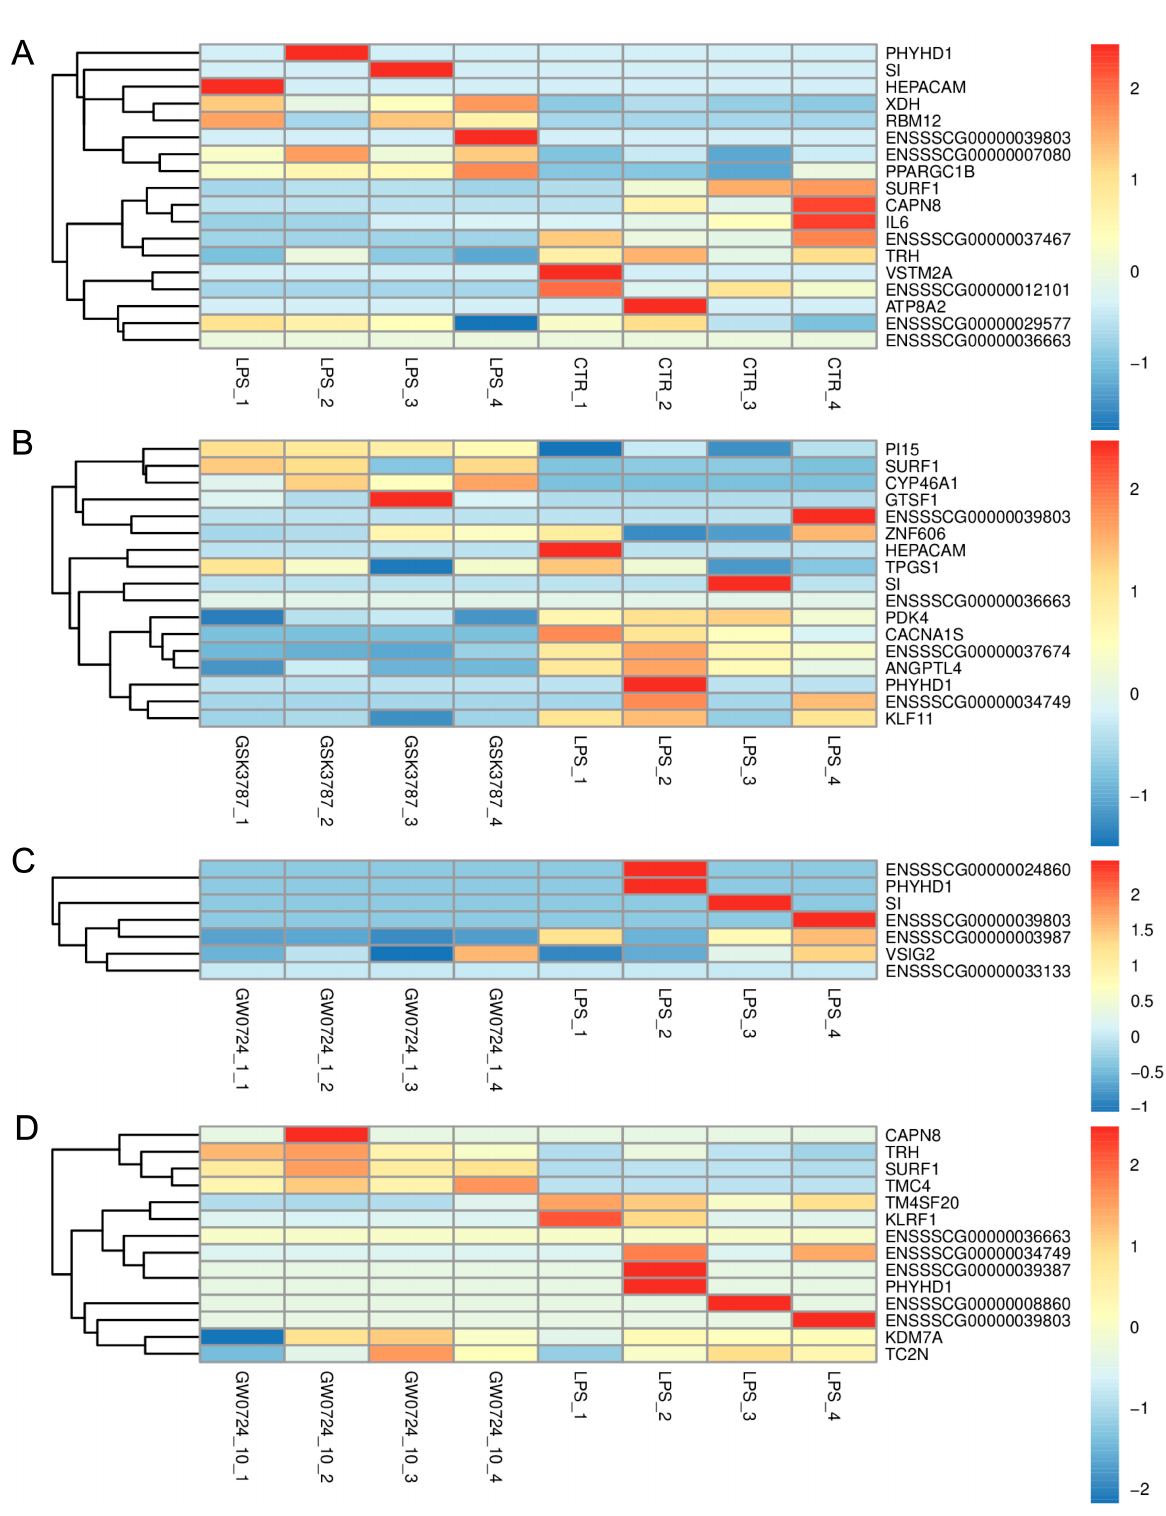
Figure 3. Hierarchical clustering heatmap of differentially expressed genes after LPS ( A ), GW0724 at a concentration of 1 µ mol/L ( B ), GW0724 at a concentration of 10 µ mol/L ( C ), or GSK3787 ( D ) treatment of porcine corpus luteum in the late-luteal phase of the estrous